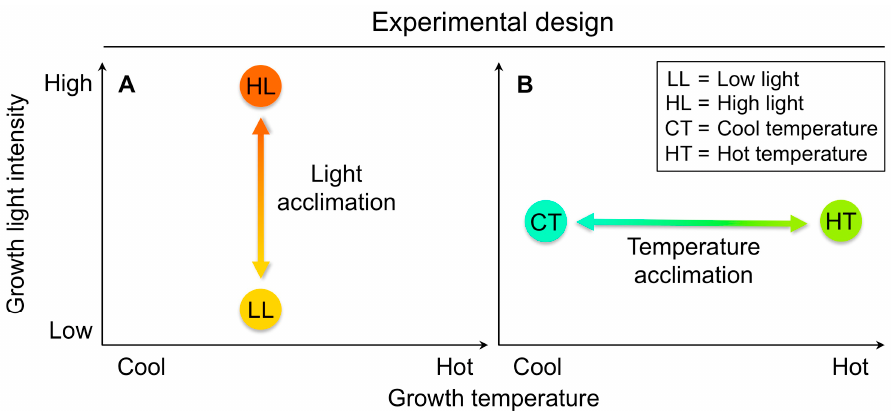
Figure 3. Schematic depiction of the experimental design used to assess ( A ) light acclimation and ( B ) temperature acclimation of phenotypic traits (see e.g., Stewart et al. [71]). LL, HL—growth light intensities of 100 and 1000 µmol photons m − 2 ·s − 1 , respectively, at a leaf temperature of 20 °C during the light period; CT, HT—leaf temperatures of 14 °C and 36 °C, respectively, under a growth light intensity of 400 µmol photons m − 2 ·s − 1 .